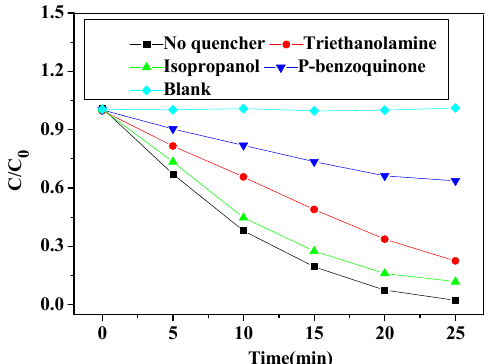
Figure 11. Results of free radical capture experiment during RhB degradation.